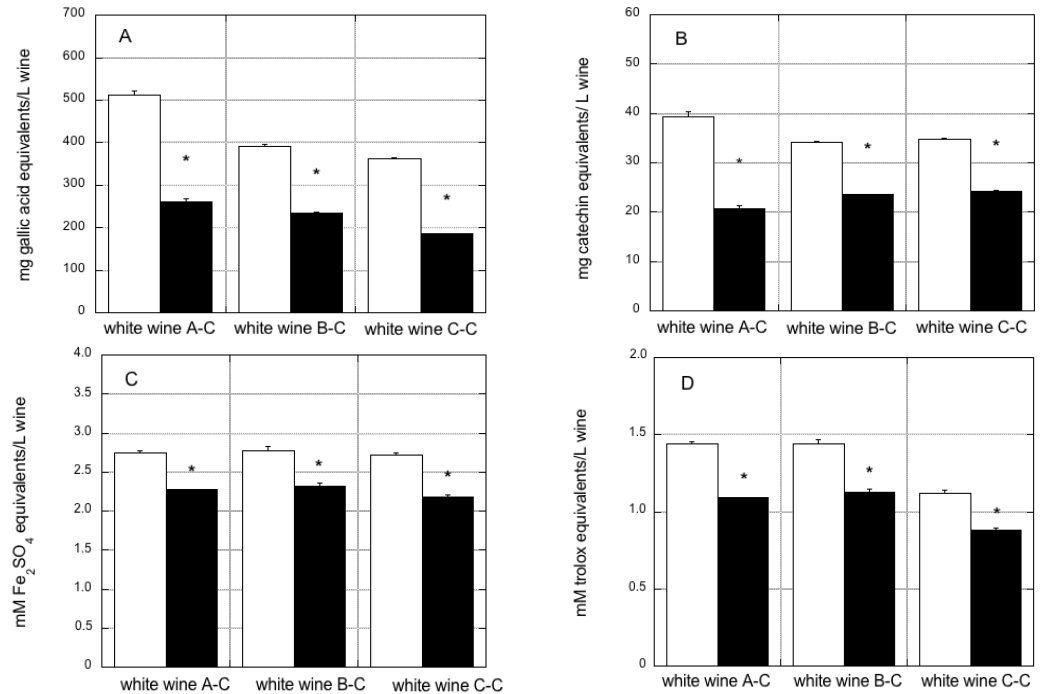
Figure 7. Effect of PVPP treatment on polyphenol, flavonoid, and antioxidant activity measurements of three conventional white wines. Polyphenols content ( A ), flavonoids content ( B ), and antioxidant activity were measured with the FRAP assay ( C ) and the ABTS assay ( D ). Open white bars: measurements were performed on untreated wines. Closed grey bars: values measured for untreated wine were subtracted from the values measured in the corresponding supernatant obtained after PVPP treatment. This represents the contribution of sulfites and of other non-phenolic reducing compounds. Data are means ± SE ( n = 6). * p < 0.0001, relative to the untreated wines, by Student t -test.